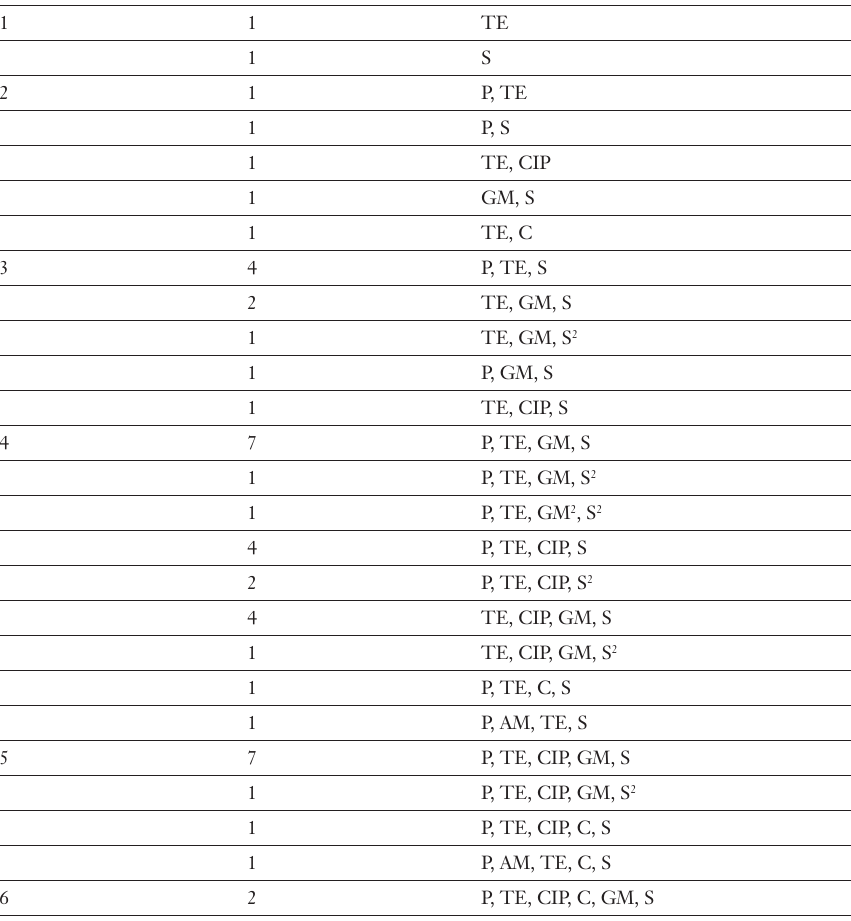
Table 1 Resistance patterns in the 50 VRE